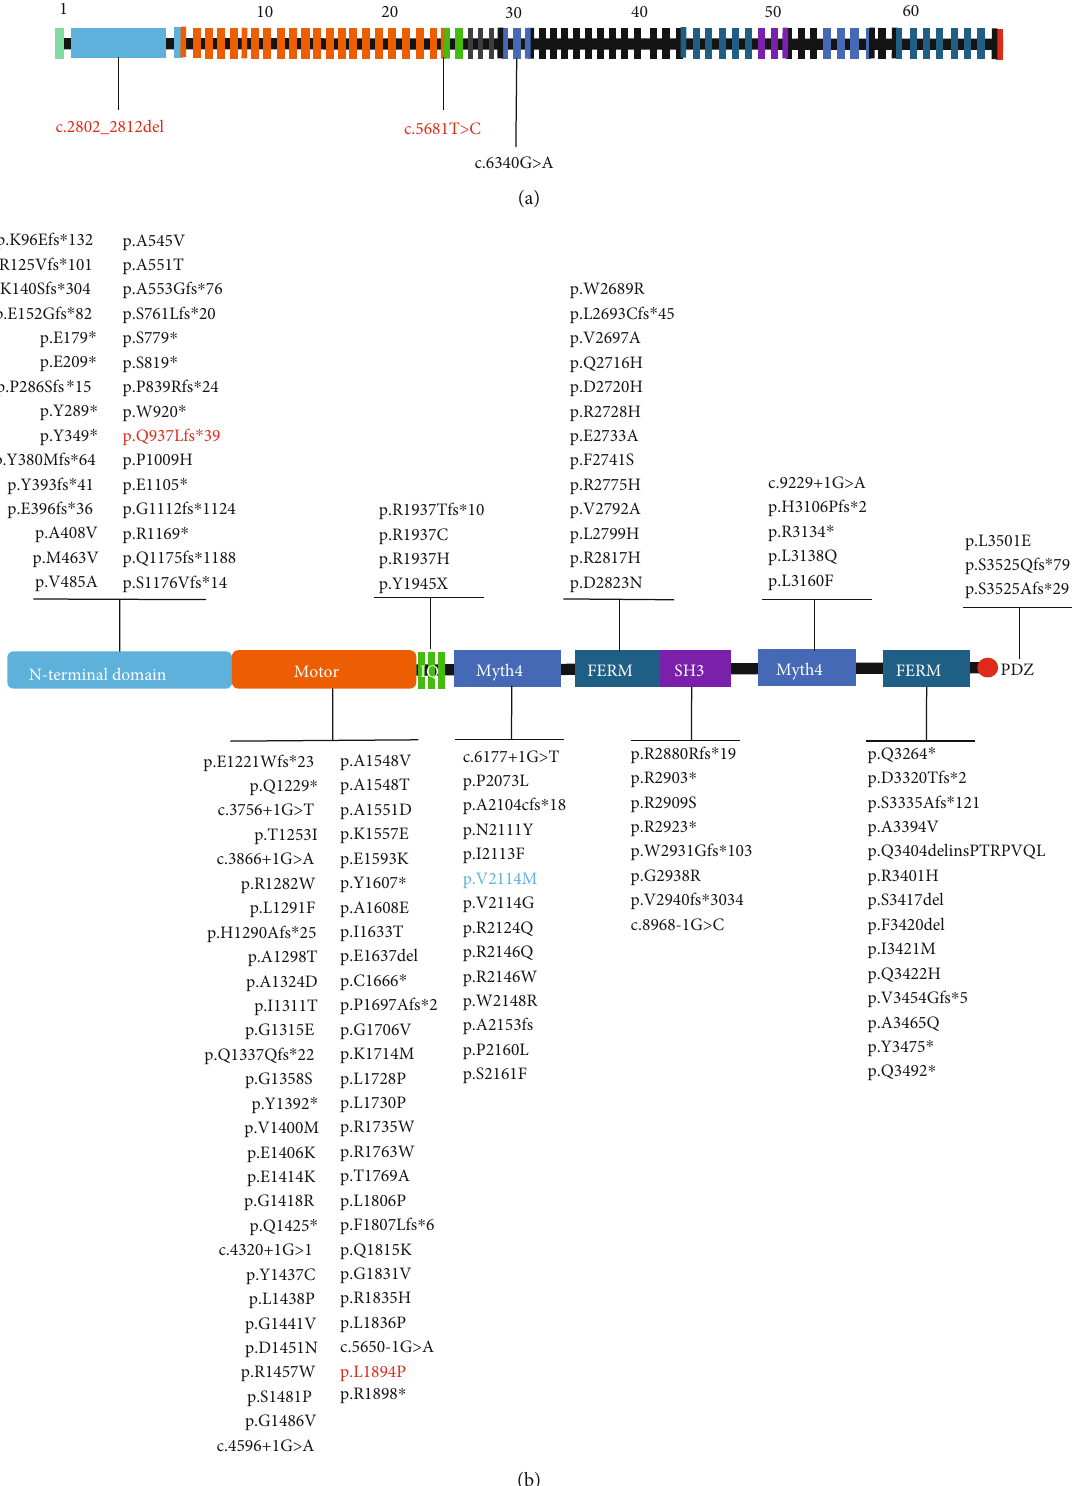
Figure 3: (a) Schematic diagram of 66 exons of the MYO15A gene is shown with all pathogenic mutations (arrows) of two families. Novel compound heterozygous MYO15A mutations are indicated in red. Previously reported mutation is indicated in black. (b) Overview of the reported MYO15A variants and their locations in the protein structure. The red words indicate the novel mutations, and the blue one refers to the reported variant that was detected in the proband in this